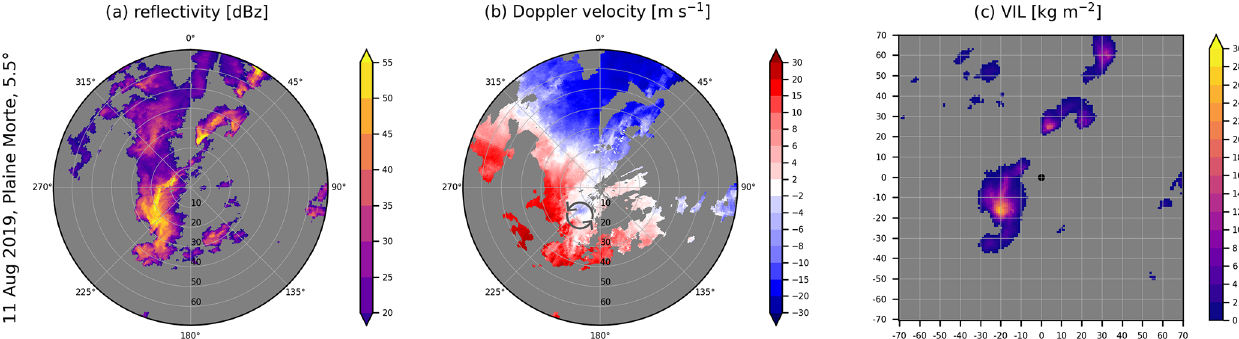
Figure D1. Supercell in Valais, 11 August 2019.